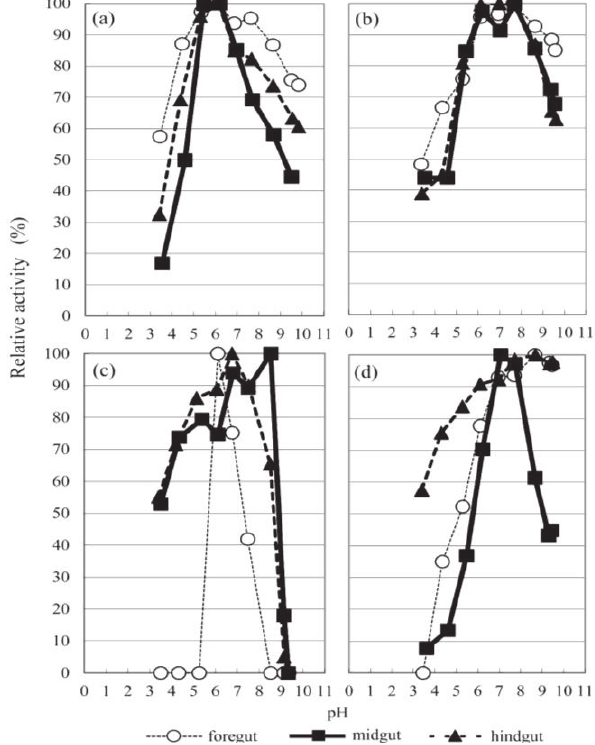
Figure 2. The pH profile of glycanases from the digestive tract of T. dichotomus larvae.